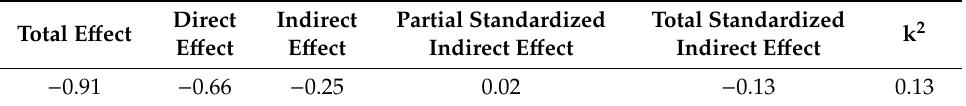
Table 6. Model 2 e ff ect indices. In the table, the coe ffi cients for all the e ff ects of the mediation model number 2 are presented.